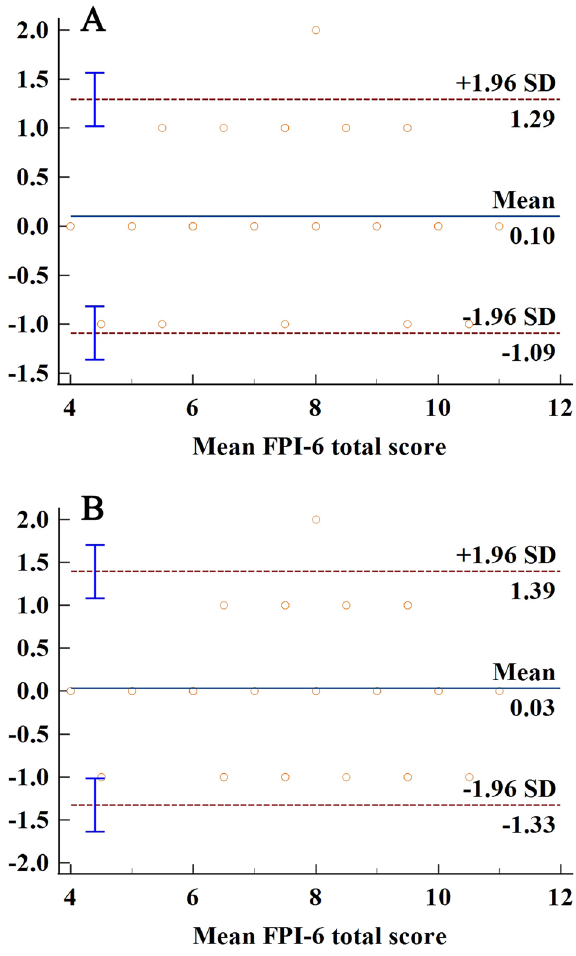
Figure 1. Bland–Altman plots of FPI-6 total score for inter-rater ( A ) and test–retest ( B ).